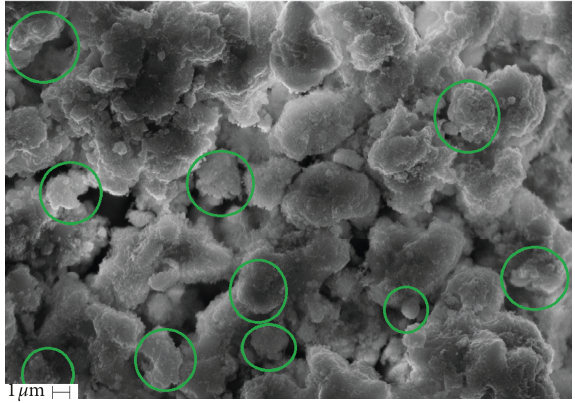
Figure 4: SEM image ( reaction.